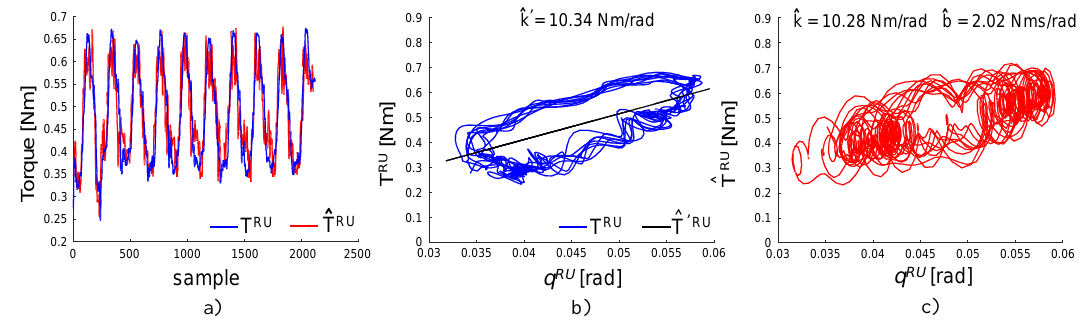
Figure 4. Result of impedance identification during the validation experiment with a robot. ( a ) Measured torque T RU vs. estimated torque (cid:98) T RU . ( b ) Estimated torque (cid:98) T (cid:48) RU using an elastic model. ( c ) Estimated torque (cid:98) T RU with visco-elastic model.